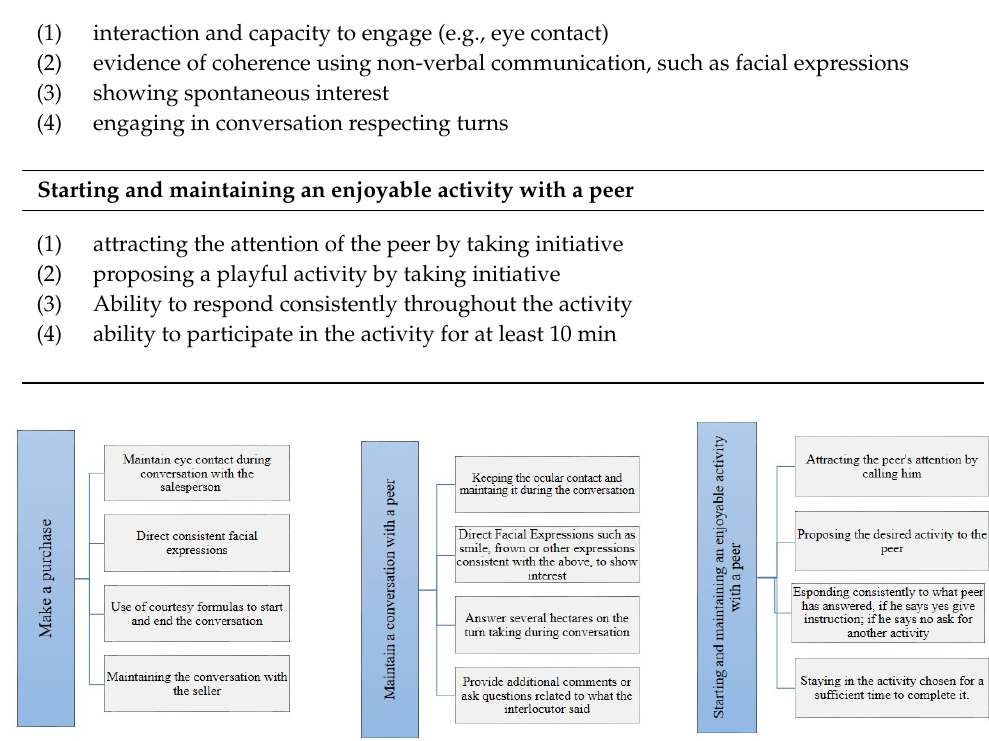
Figure 1. Subdivision of tasks .